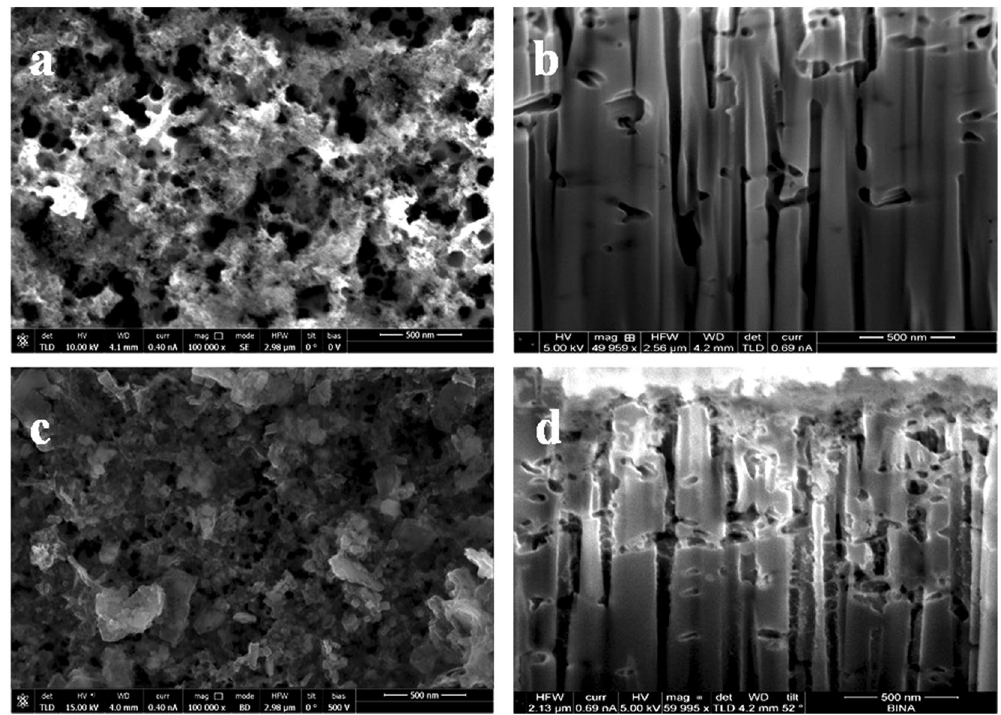
Figure 2. ( a ) Plane-view SEM image of the pSi substrate, ( b ) cross-section SEM image of the pSi substrate after focused ion beam etching, ( c ) plane-view image of the pSi/ZnO NS and ( d ) cross-section image of the pSi/ZnO